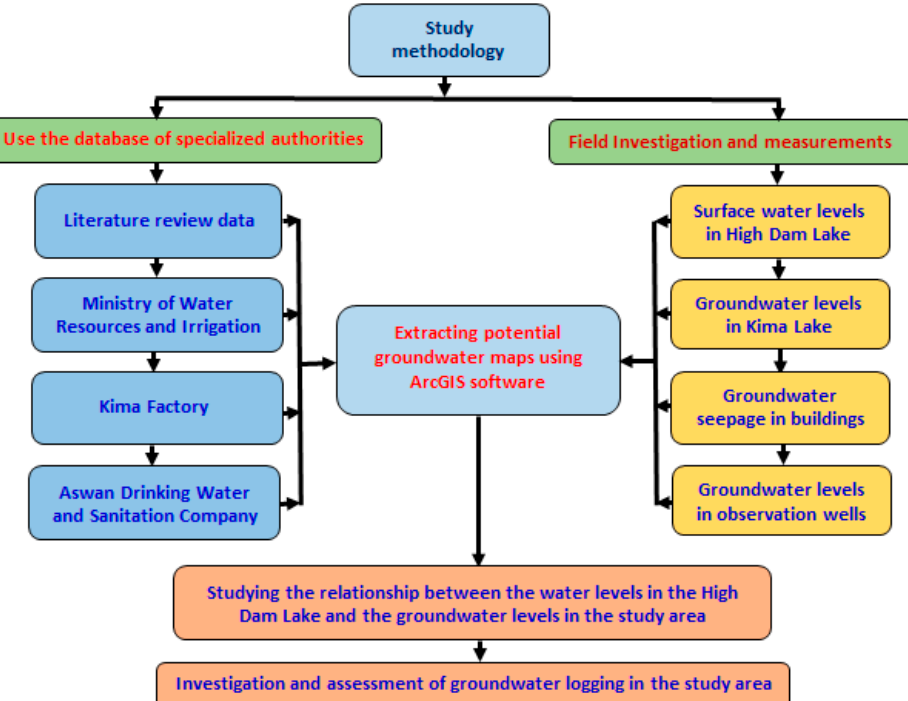
Figure 3. Methodology adopted in the present study.